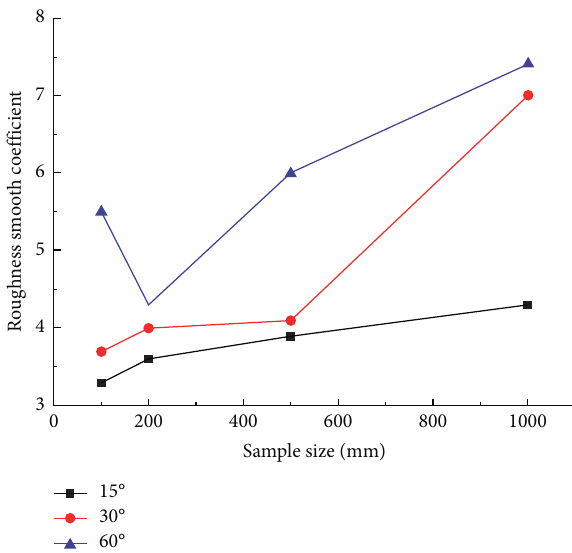
Figure 10: Roughness smooth coefficient of JRC values in different azimuthal intervals.